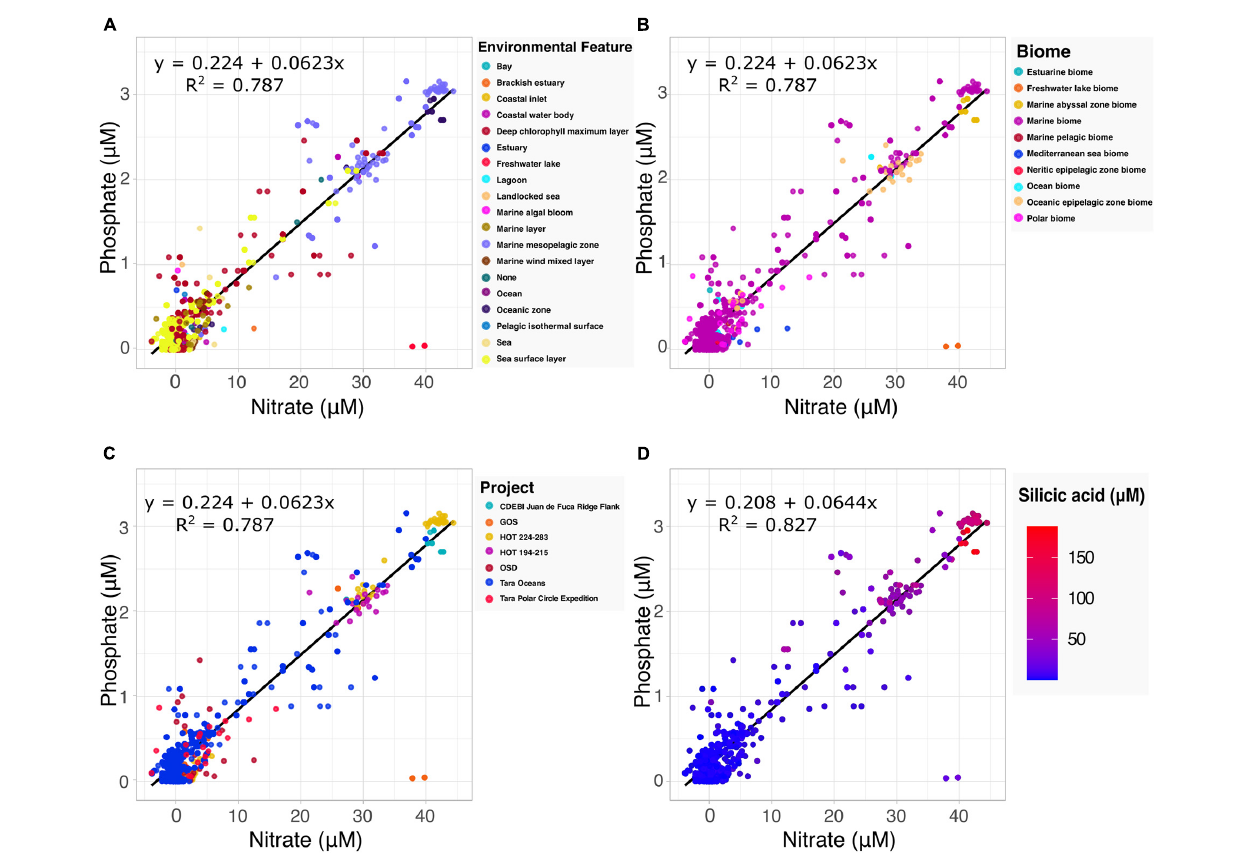
FIGURE 2 | Examination of the Redfield ratio, the relationship between phosphate and nitrate concentrations, faceted by the various harmonized metadata types included in the Planet Microbe Data Packages. (A) The Redfield ratio colored by the 18 ENVO environmental feature types [e.g., “ bay ” (ENVO:00000032)]. (B) The Redfield ratio colored by the 10 ENVO biome types [e.g., “ estuarine biome ” (ENVO:01000020)]. (C) The Redfield ratio colored by the project name for the seven projects that include both phosphate and nitrate data. (D) The correlation between silicic acid and the Redfield ratio for a subset of the data shown in (A–C) that also include silicate data. Linear equations modeling phosphate as a function of nitrate and R 2 are displayed in the panels. Nitrate, phosphate, and silicic acid are reported in micromolar